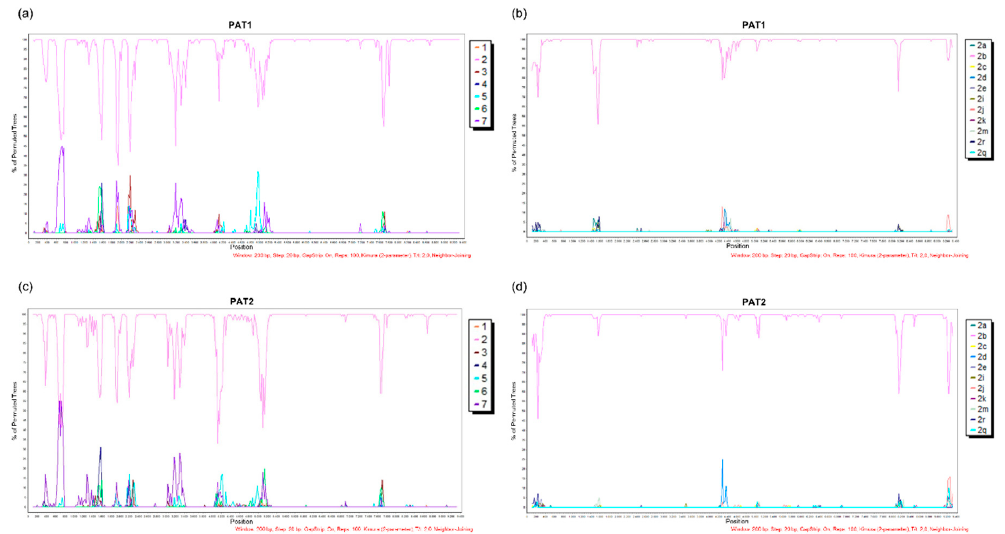
Figure 2. Analysis of potential recombination events of the PAT1 and PAT2 isolates. ( a ) BootScan plot of the PAT1 and HCV genotypes. ( b ) BootScan plot of the PAT1 and HCV-2 subtypes. ( c ) BootScan plot of the PAT2 and HCV genotypes. ( d ) BootScan plot of the PAT2 and HCV-2 subtypes. The parameters used for analysis are shown at the bottom of the figures. All analyses were performed within a window of 200 bp and step size of 20 bp under the Kimura 2-parameter